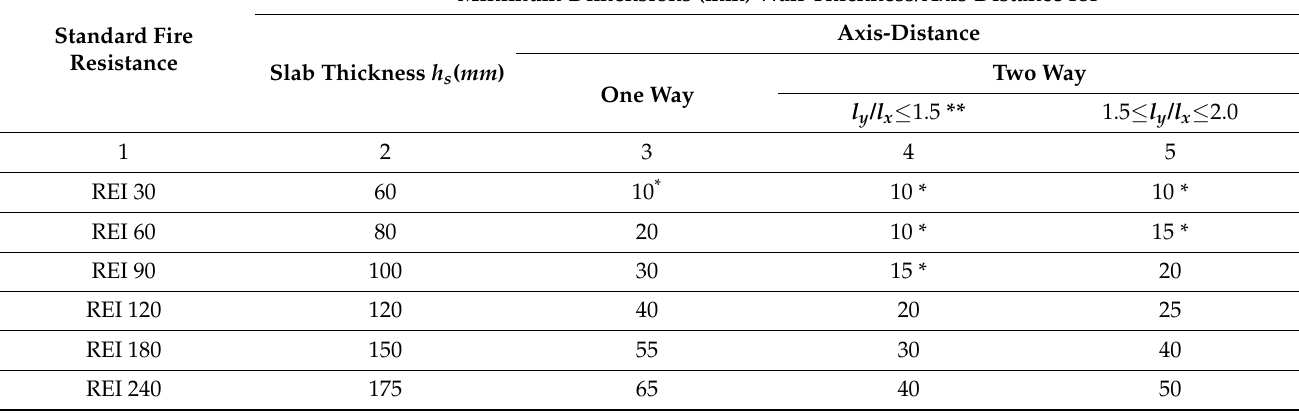
Table 5. Minimum dimensions and axis distances for reinforced and prestressed concrete simply supported one-way and two-way solid slabs (EN1992-1-2